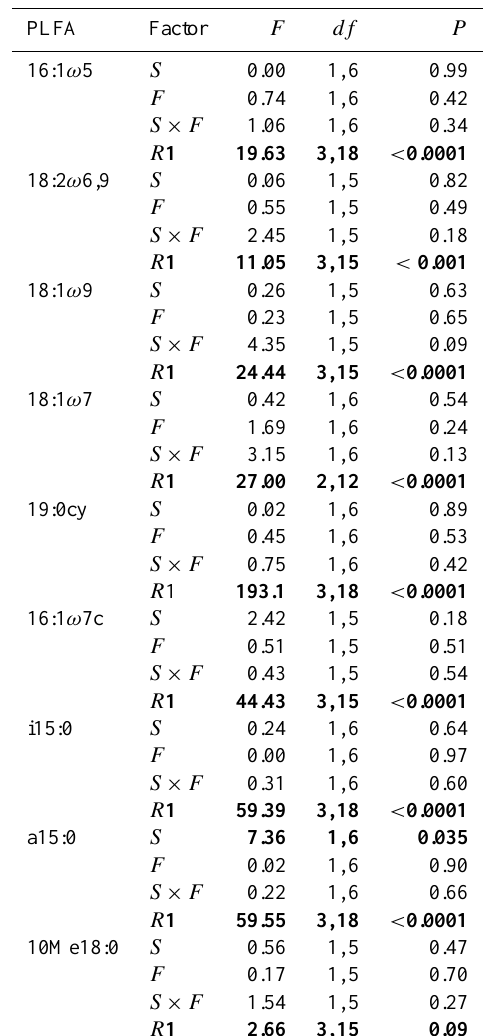
Table 2. Repeated measures ANOVA results across sampling time (R1) for 13 C enrichment in soil microbial PLFAs as affected by restoration management treatments (seed addition S , fertiliser use F , and their interaction S × F ). Results of interactions between restoration factors and R 1 and of block not shown as none were significant, apart from a small block effect for PLFA 18:2 ω 6,9 ( F 2 , 5 =10.97, P < 0 . 05). Statistical significant factors in bold.